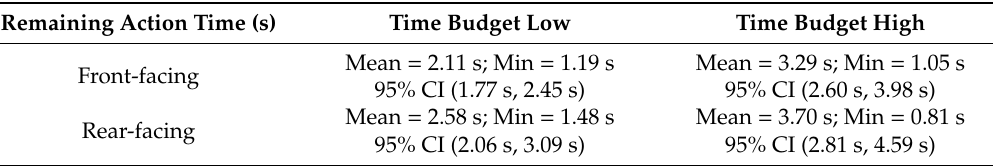
Table 2. Remaining action time results from different conditions.